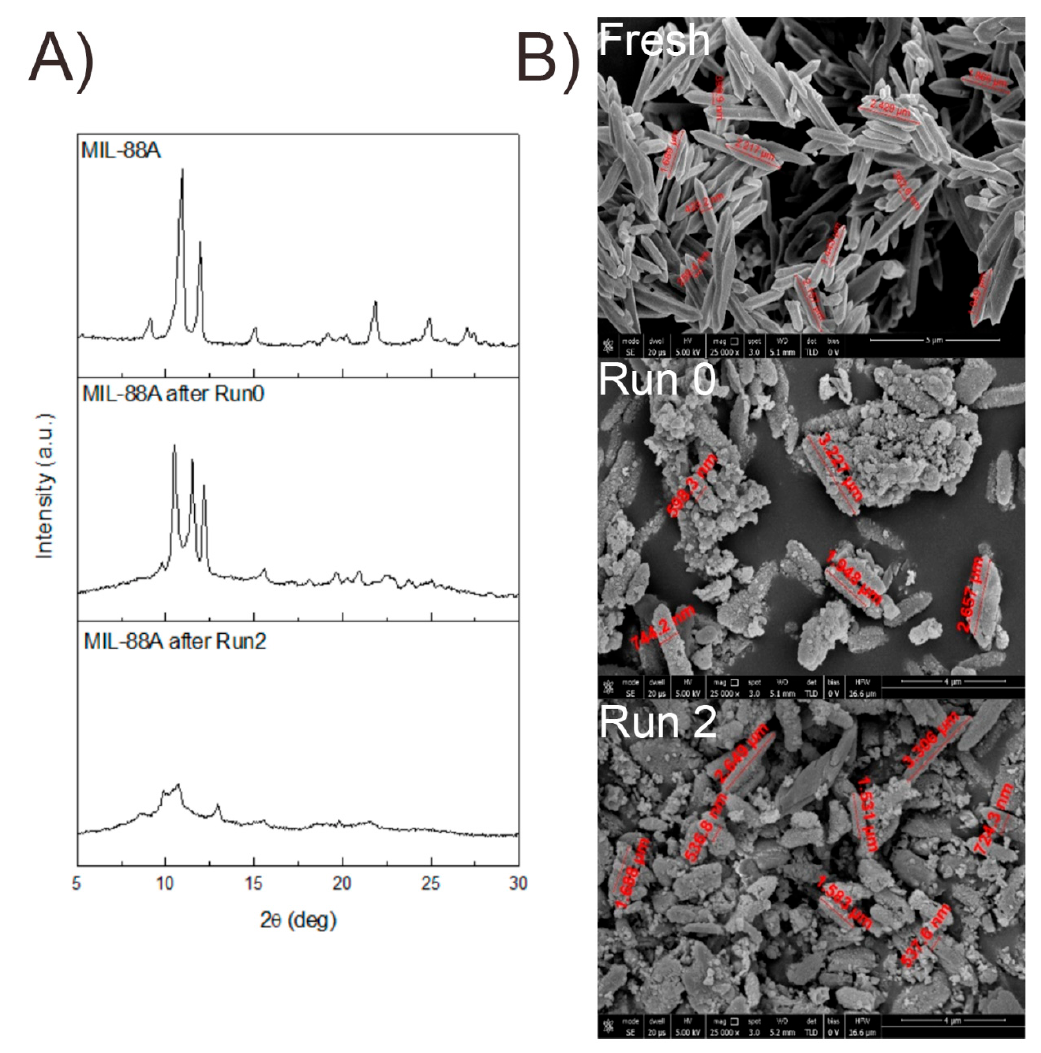
Figure 5. Comparison of diffraction patterns ( A ) and SEM images ( B ) of fresh MIL-88A used at 120 °C (Run 0 Run 2).